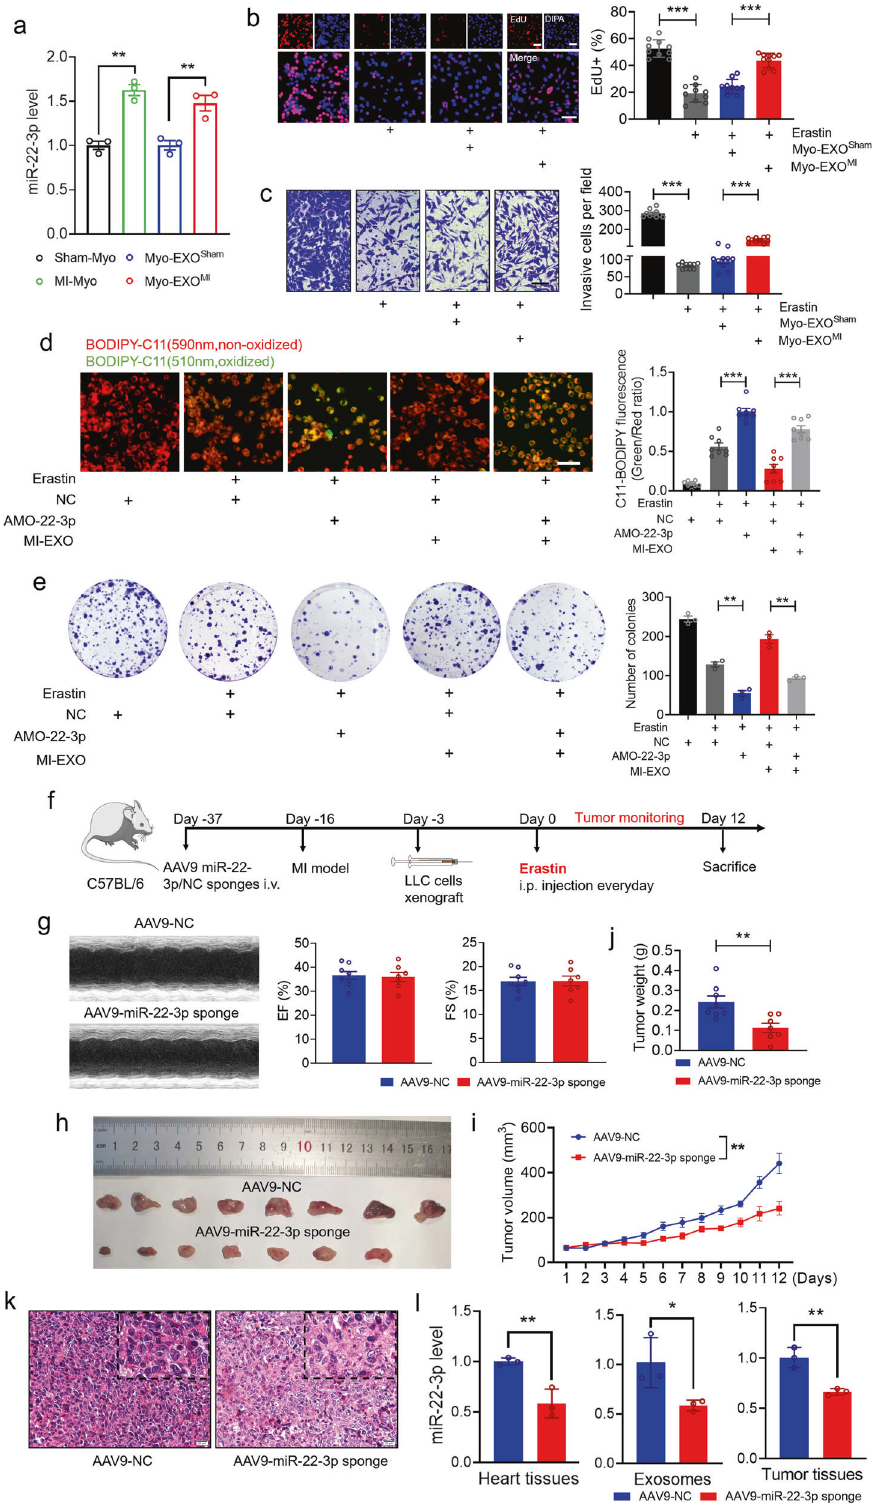
and cancer and the mechanisms are complex, and we are still facing many challenges in this new fi eld. Ferroptosis has attracted overwhelming interest from researchers worldwide due to its relevance to degenerative diseases including ischemic injury, organ failure, neurodegeneration, and therapy-resistant tumors.